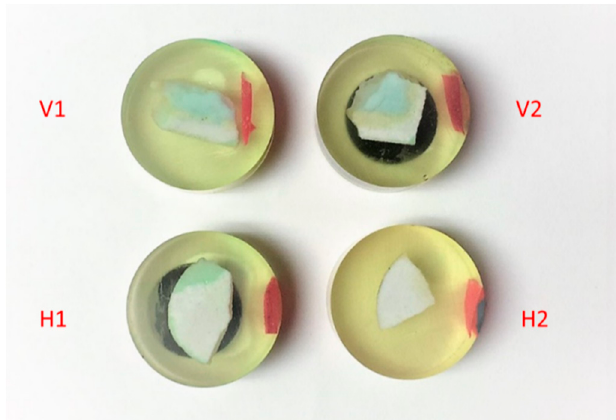
Figure 2. 3D printed rock fragments for nanoindentation experiments. ‘V’ represents vertical, and ‘H’ denotes horizontal.